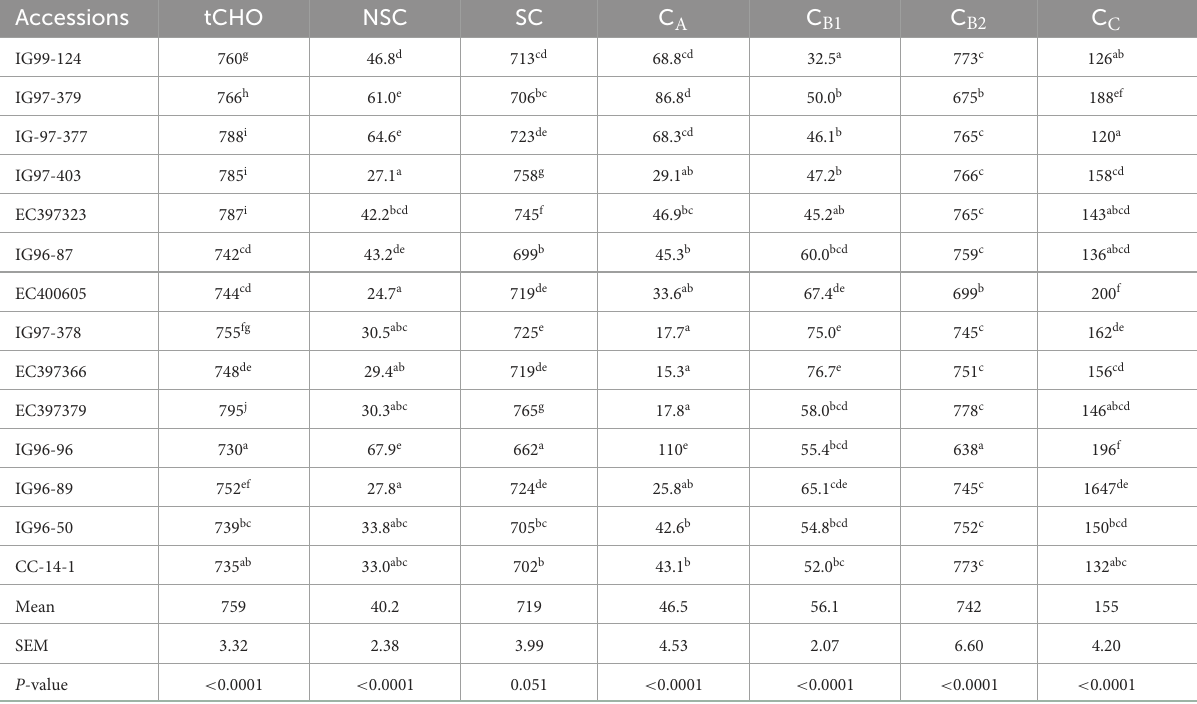
TABLE 3 Carbohydrate fractions of sugar-rich Cenchrus ciliaris